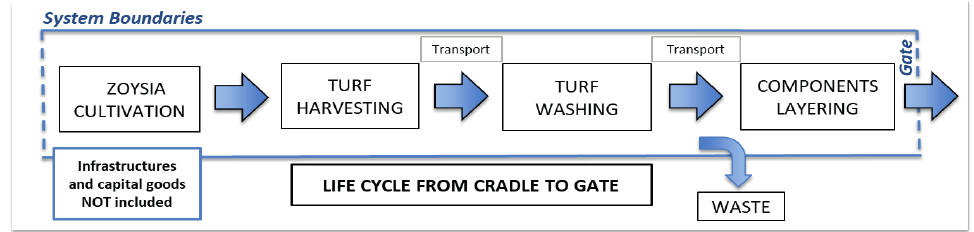
Fig. 2. Pratotetto ® production process and system’s boundaries